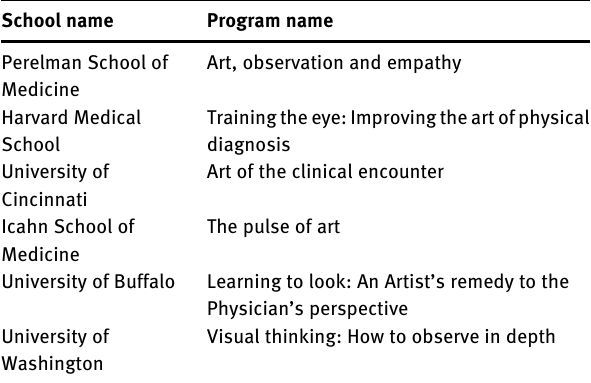
Table  : Examples of visual thinking programs applied in several medical schools.